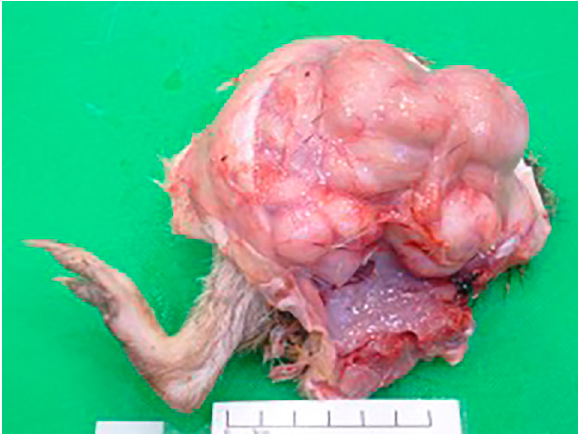
Figure 1. A smooth, pale tan, multilobulated mass circumferentially surrounds the right femoral-tibial joint of an adult female I. macrourus .